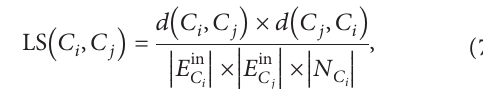
Algorithm 1 constructs the initial community structure